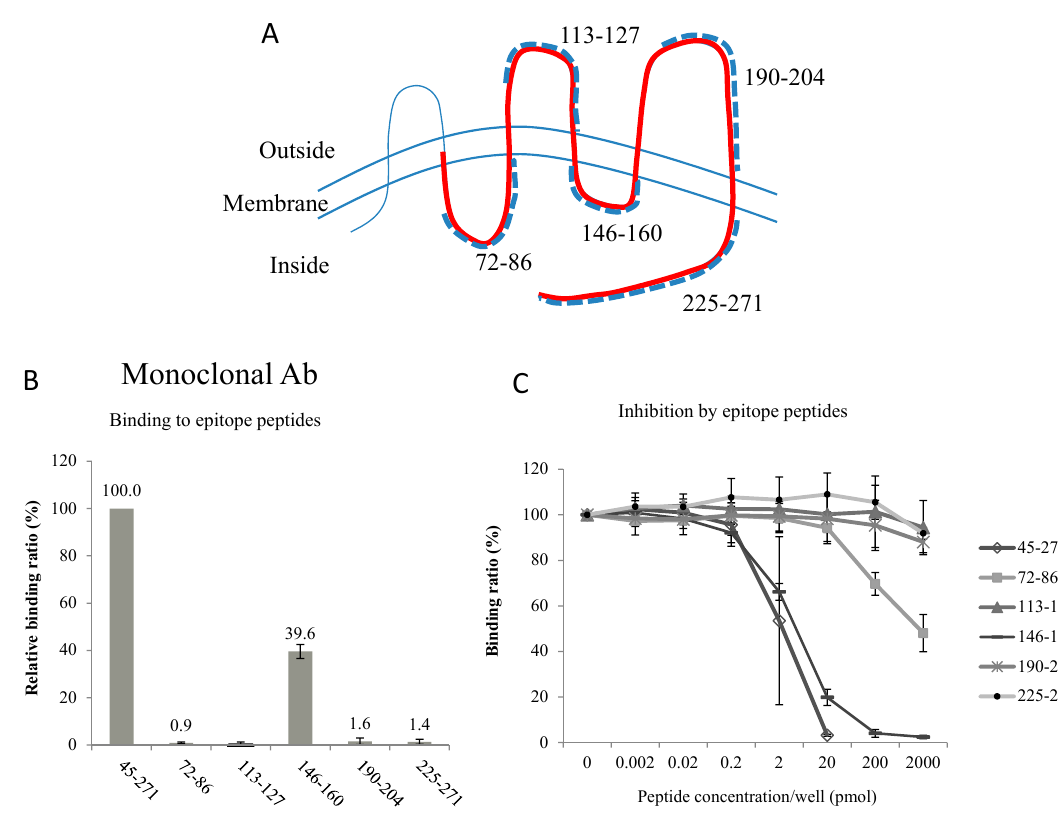
Figure 3. Determination of epitopes of the monoclonal antibody. ( A ) Topology of aquaporin-2 (AQP2) molecule with six transmembrane domains with N- and C-terminus inside the cell. Bold red line indicates the immunogen sequence (45–271) and dotted bold lines are synthetic peptides used for binding assay ( B ) and competitive inhibition assay ( C ).